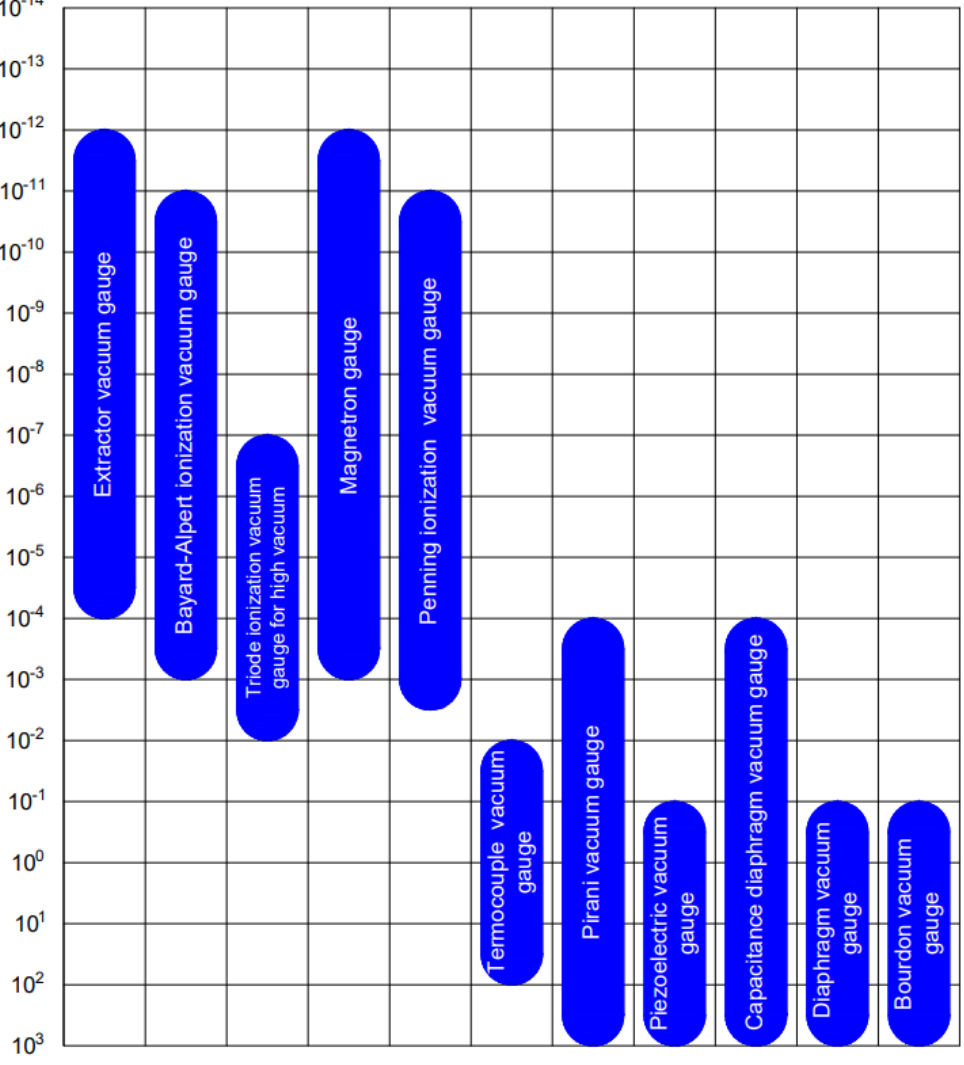
Figure 6. Pressure measurement methods designed to detect different pressure levels [59].